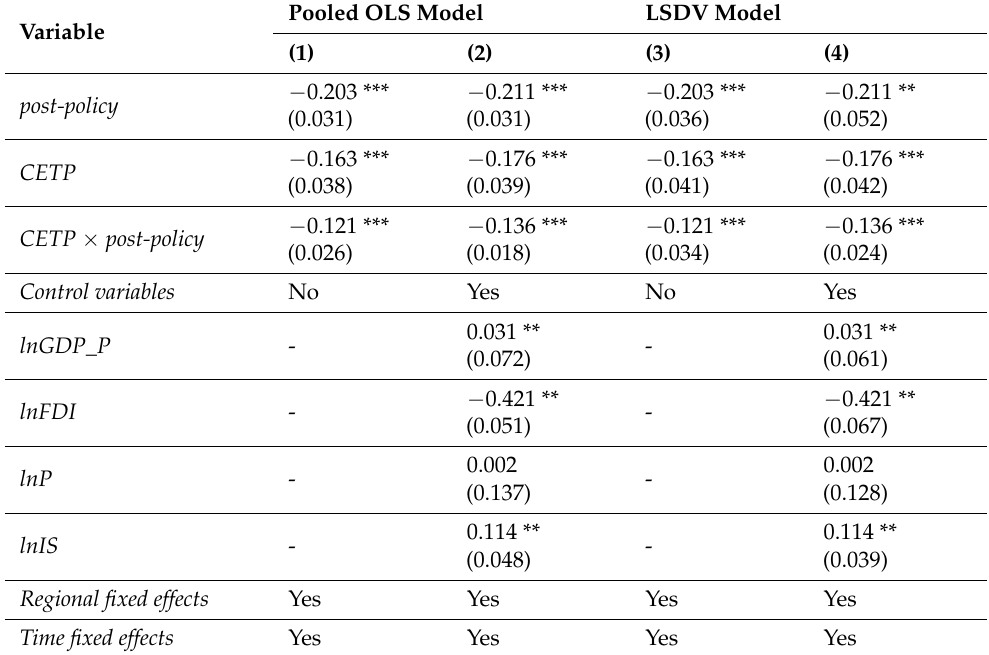
Table 3. Impact of CETP on carbon